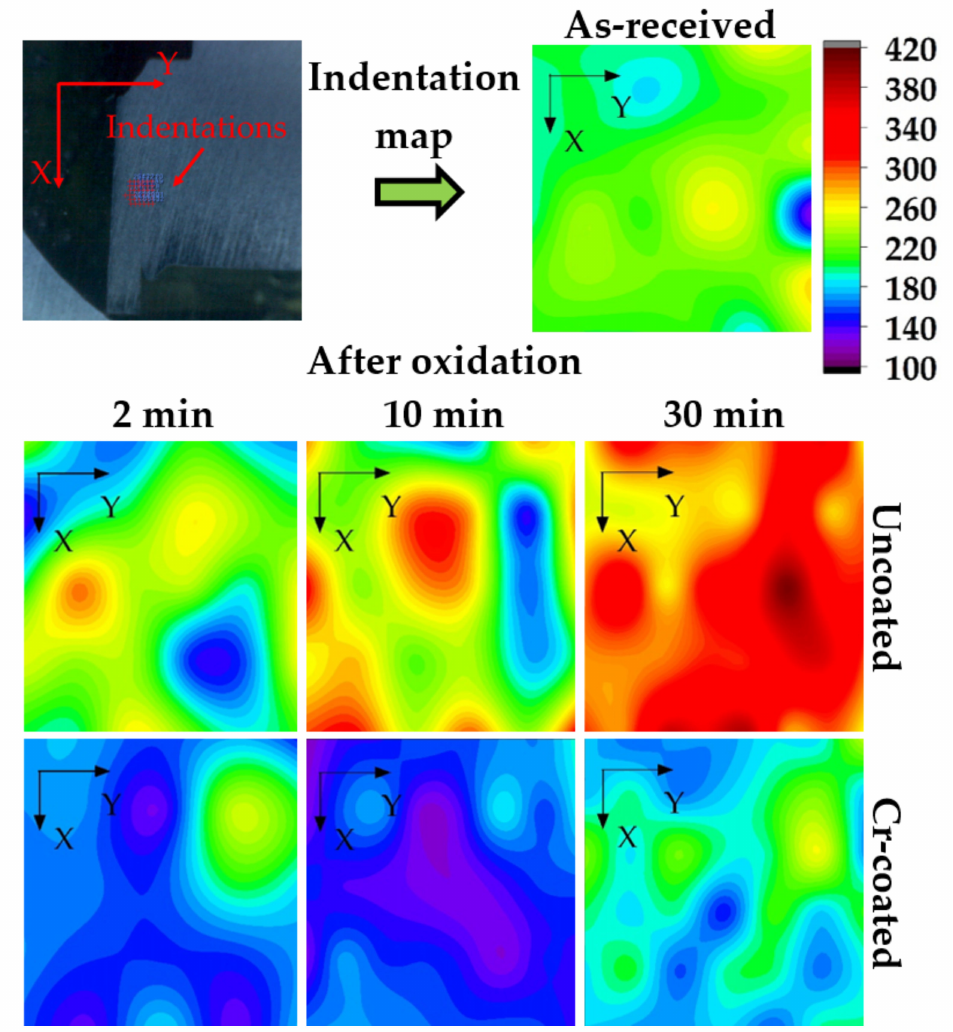
Figure 9. Hardness map (in HV) of the cross-section of RUW welds before and after oxidation at 1100 ◦